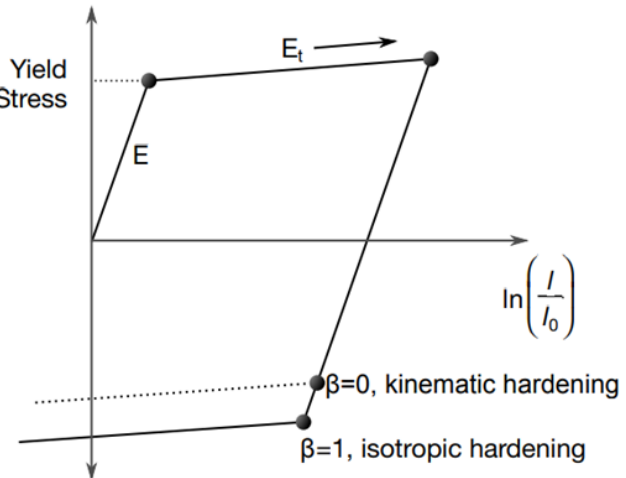
Figure 2. Elastic-plastic behavior with kinematic and isotropic hardening where 𝑙 0 and 𝑙 are unde- formed and deformed lengths of uniaxial tension specimen. 𝐸 𝑡 is the slope of the bilinear stress strain curve. Table 2. Material parameters of the plastic kinematic model.